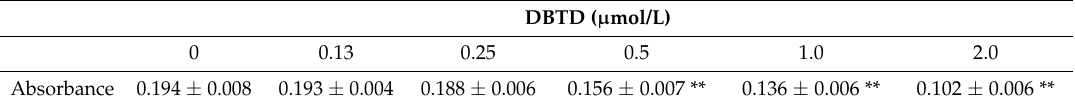
Figure 3. Triglyceride (TG) contents in HL7702 cells treated with different concentrations of DBTD (0, 0.13, 0.25, 0.50, 1.00, and 2.00 μmol/L) for 24 h. The TG concentrations were normalized to the